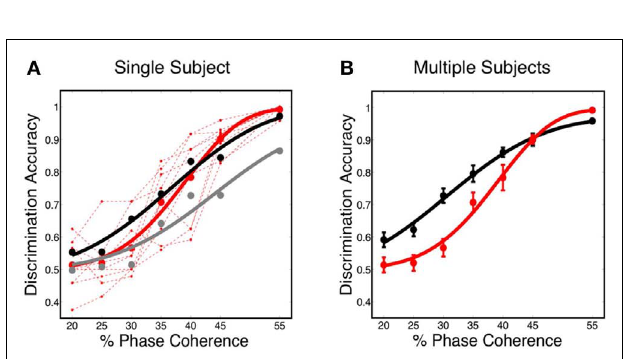
FIGURE 7 | (A) Simulated neurometric performance for one initialization of theV1 model. Shown are (black) neurometric curve constructed by decoding the full spatio-temporal word, D = 3.19, p = 0.53; (gray) neurometric curve constructed from a decoder that ignores dynamics, D = 52.26, p < 0.01. Also shown is (dashed red lines) the psychophysical performance of 10 human subjects, and (solid red curve) the group psychometric curve across 10 subjects. (B) Shown are (black) simulated neurometric performance averaged over five initializations of the model, together with (red) the average psychometric curve for the 10 human subjects. Error bars on both curves represent standard error. Likelihood ratio test yields D = 6.42, p = 0.17.